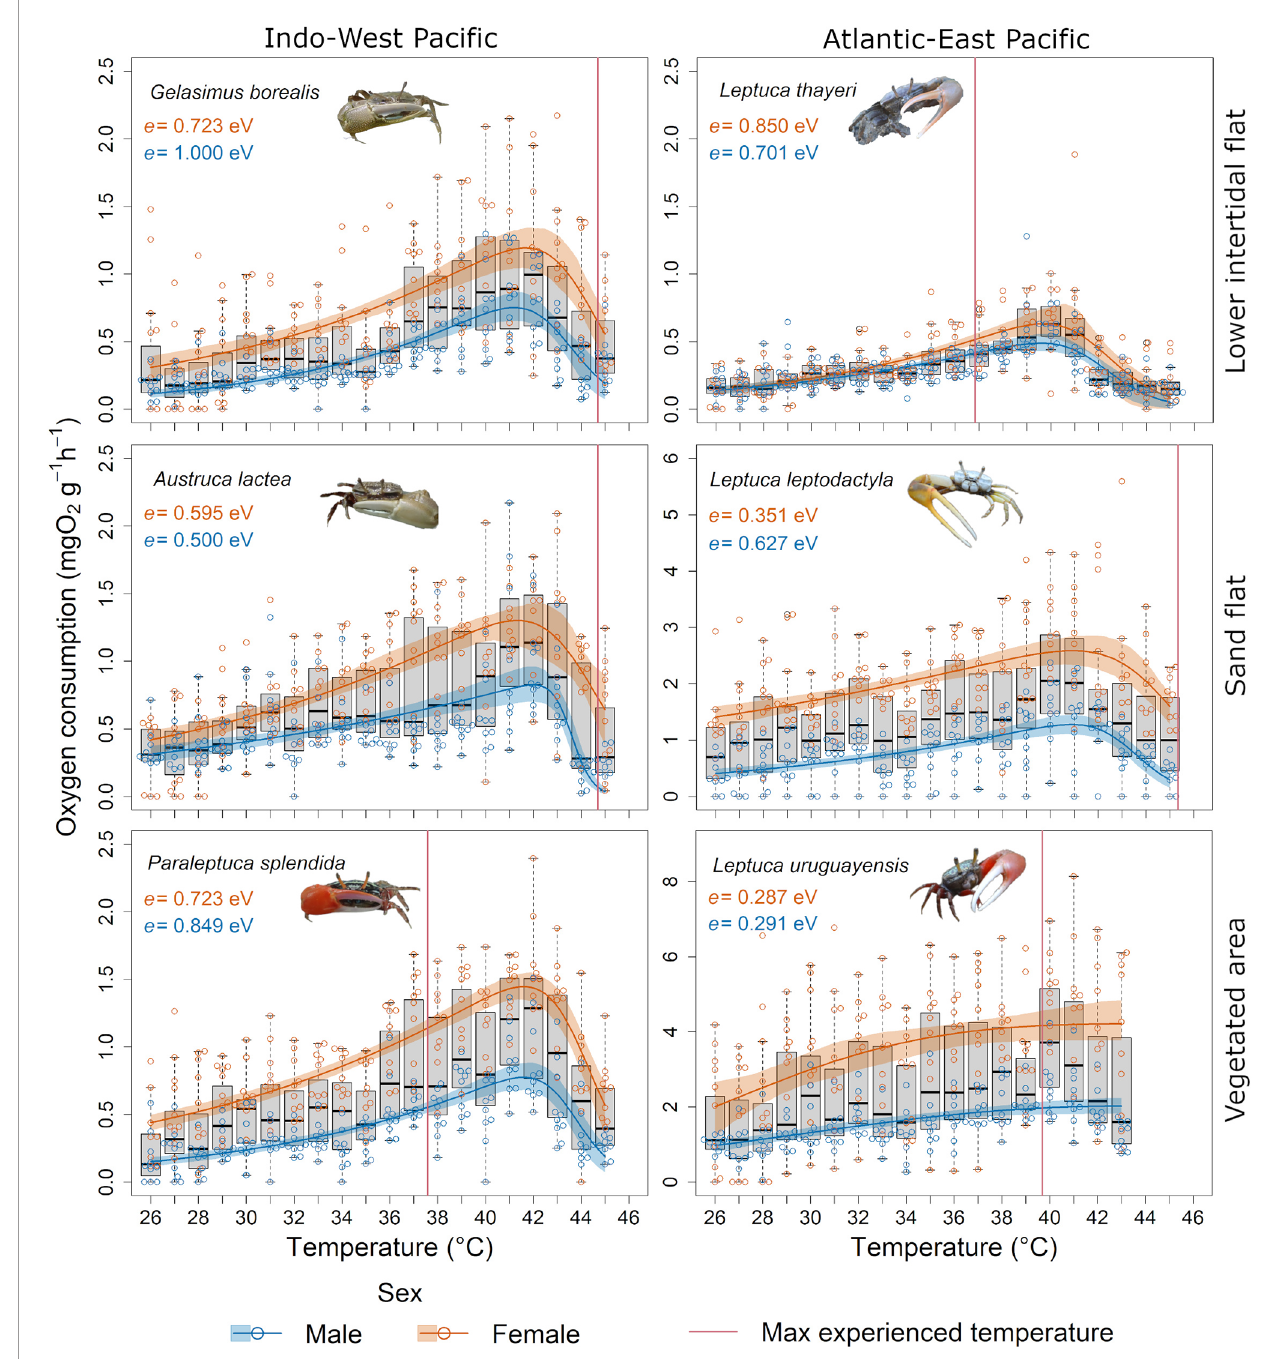
FIGURE 7 | Thermal performance curves and activation energy (e) for the oxygen consumption of the studied fi ddler crab species. Boxplots show the median, 25th and 75th percentiles, and whiskers are 1.5 times the spread beyond the hinge of MO 2 for each species. Orange and blue circles characterize raw data points for females and males, respectively. Orange and blue lines characterize raw data points for females and males, respectively. The shading represents the bootstrapped 95% con fi dence interval around the thermal performance